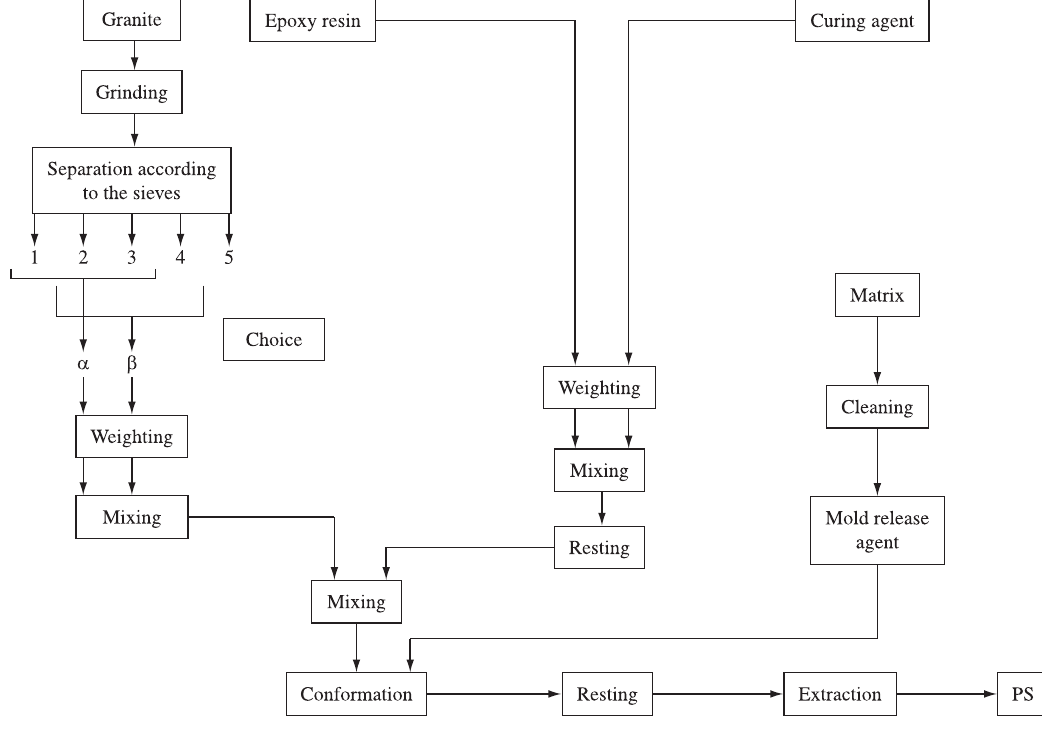
Figure 2. Probe Samples (PS) production for vibration damping tests.